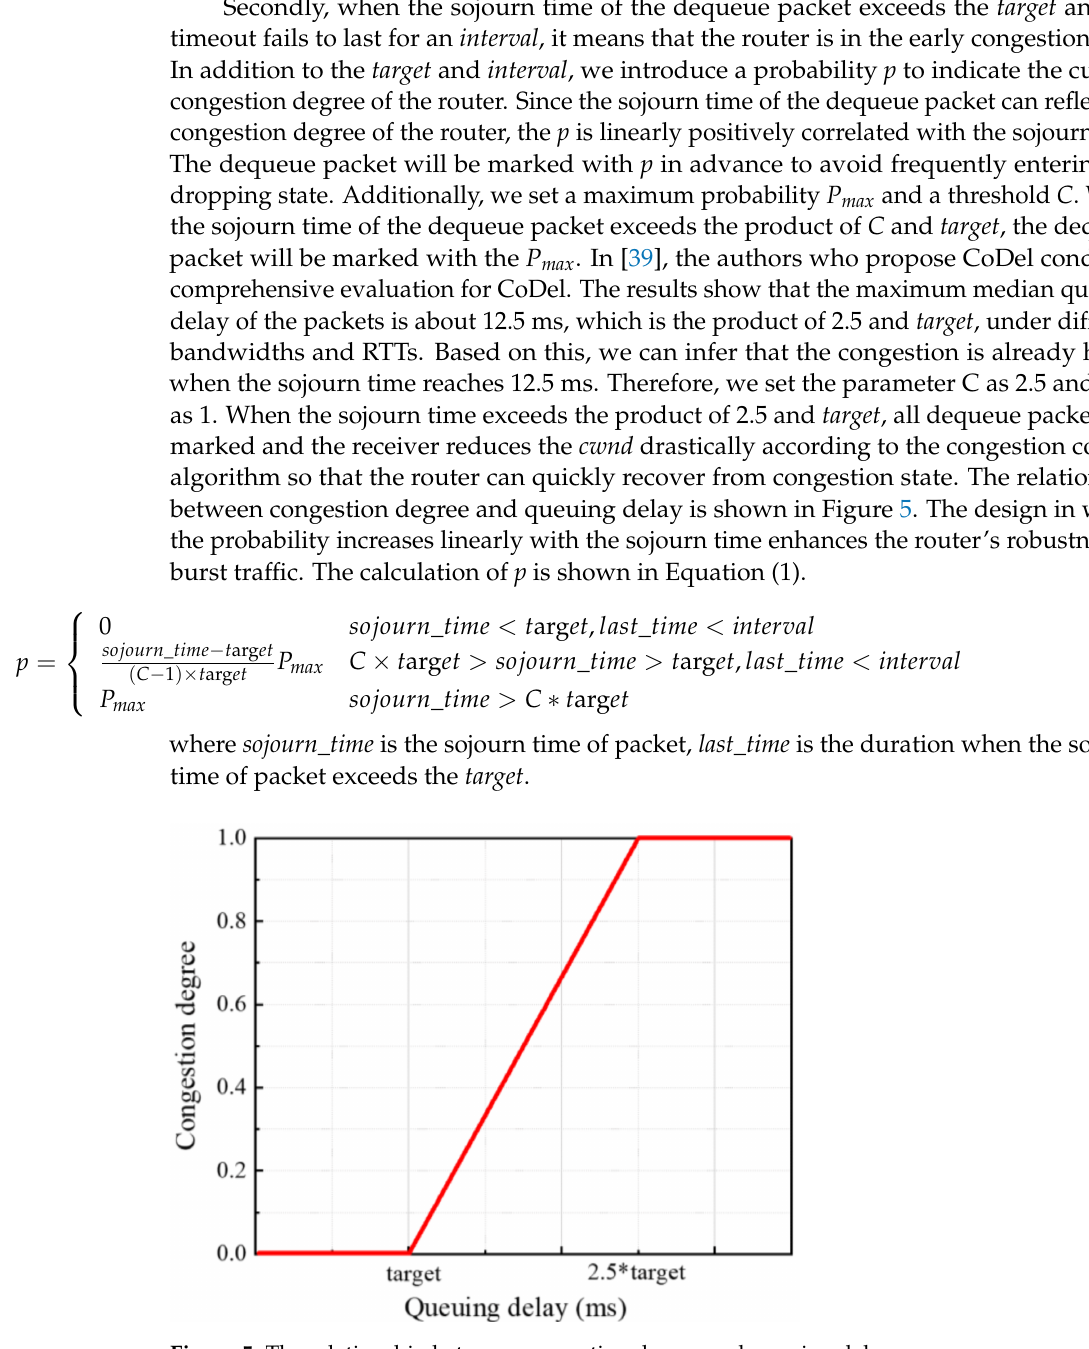
Figure 5. The relationship between congestion degree and queuing